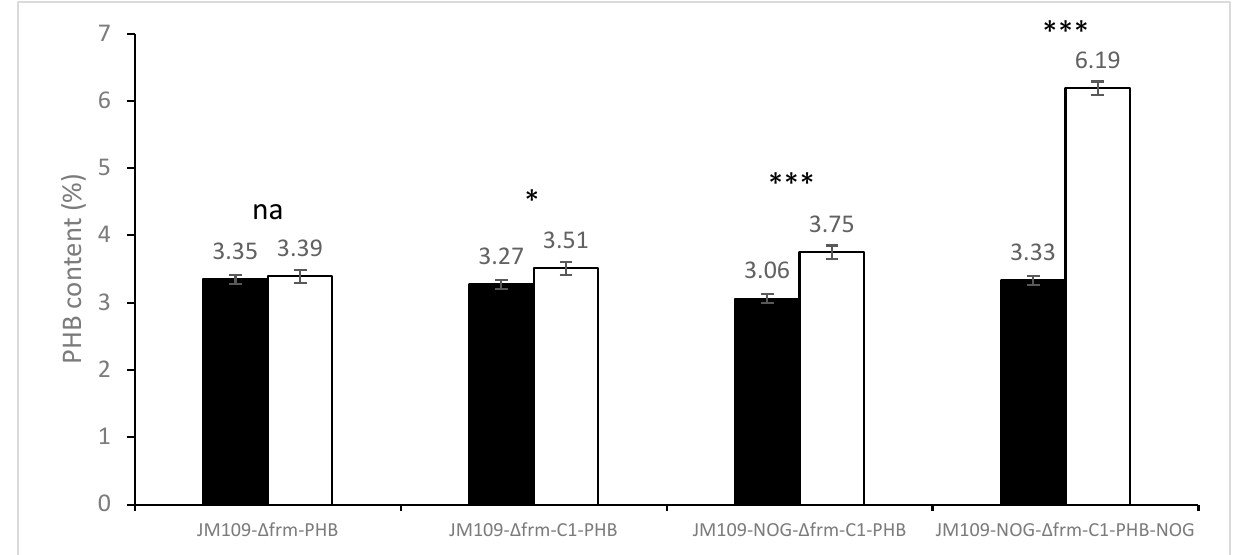
Figure 4. PHB production from different engineered E. coli strains. The introduction of the phos- phoketolase gene to form the complete MCC pathway greatly improved PHB content. JM109- Δ frm- PHB with only PHB production module was set as control. JM109- Δ frm-C1-PHB with PHB produc- tion module and C1 assimilation module was set to test the RuMP pathway. JM109-NOG- Δ frm-C1- PHB with PHB production module, C1 assimilation module, and low-expression NOG module was set to test the MCC pathway. JM109-NOG- Δ frm-C1-PHB-NOG with PHB production module, C1 assimilation module, and high-expression NOG module was also set to test the MCC pathway. Shown are the mean values of three biological replicates, and error bars indicate standard devia- tions. The dark and white columns represented engineered strains conducted using water and meth- anol, respectively. T -tests were conducted to evaluate statistical significance at p < 0.05 (*),and p < 0.001 (***).